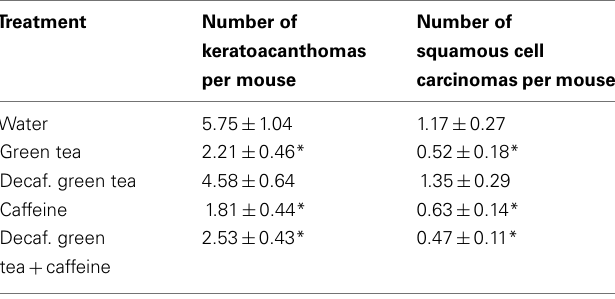
Table 1 | Effect of green tea and decaffeinated green tea on UVB-induced complete